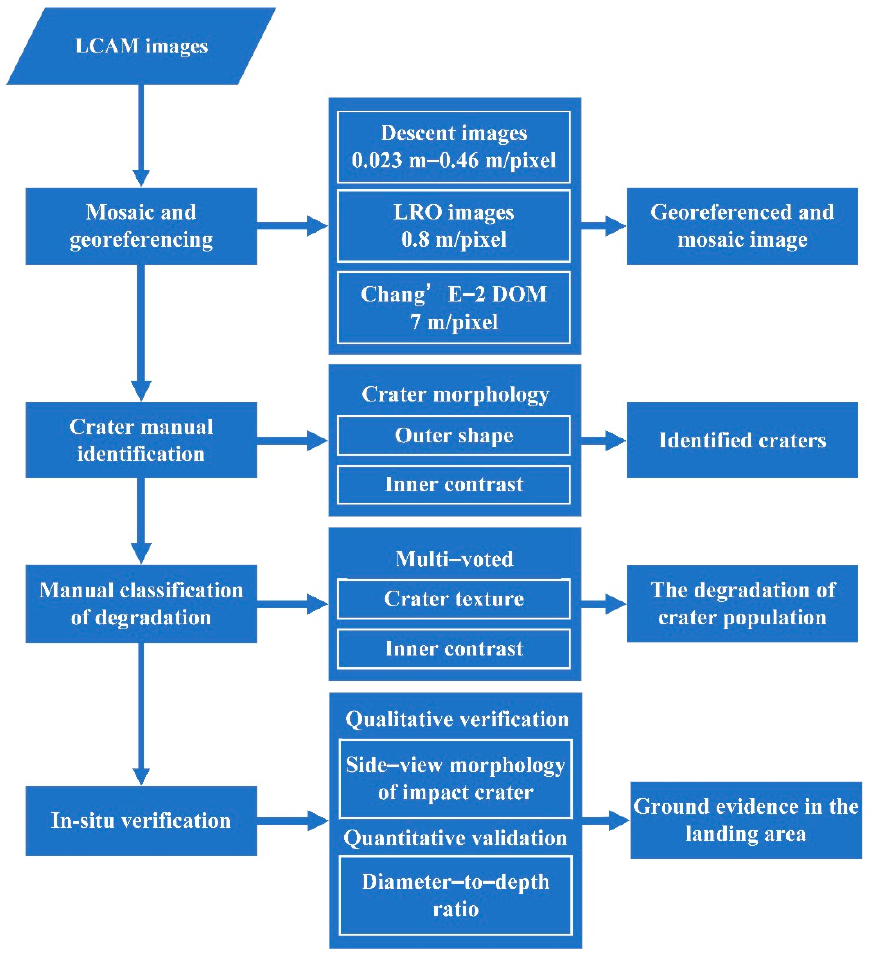
Figure 1. Flow chart of the analysis of impact crater population degradation.